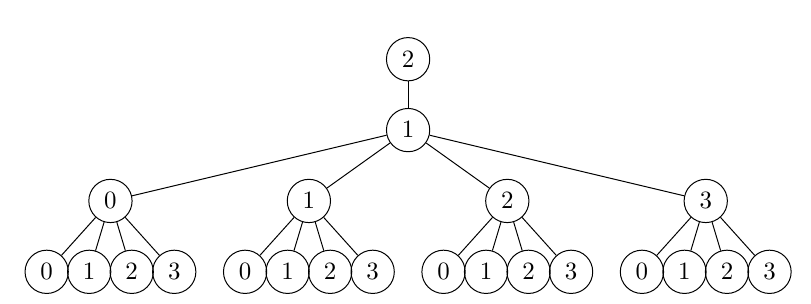
Figure 5: Best-case scenario example with parameters K = 16 and b =